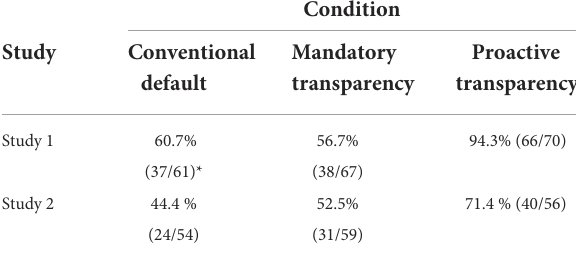
TABLE 1 Choices for the default option by experimental